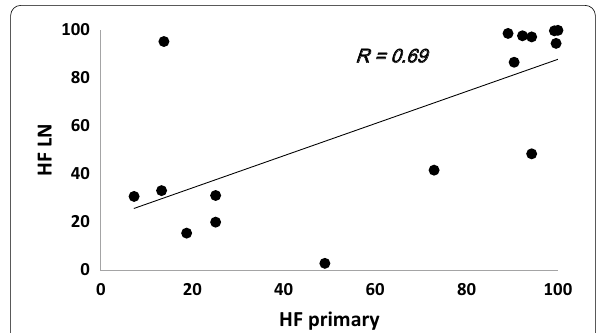
Fig. 4 Plot of the correlation between the primary tumors and LNs HF’s. A strong correlation, yet not significant (R P 0.96) between the primaries and LNs oxygenation status seems = to exist, which is in agreement with the measurement reported by Becker and in HNSCC using biopsy-based methods